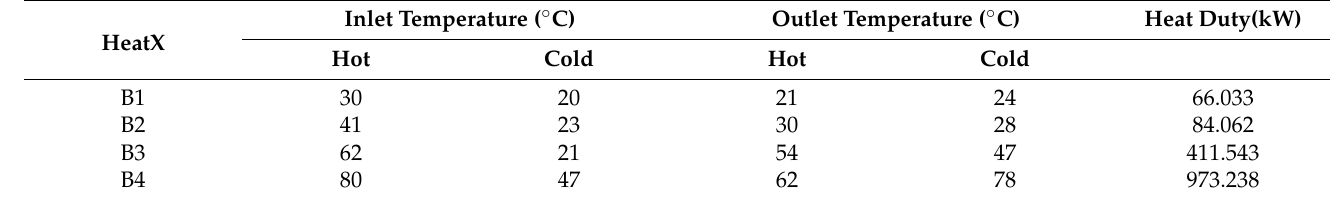
Table 3. Simulation results of heat